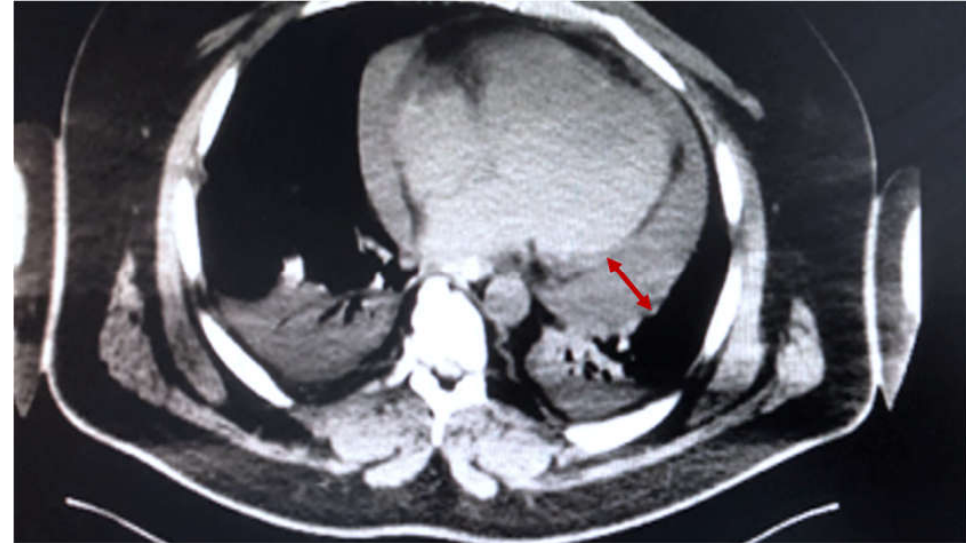
Figure 4. Thoracic CT scan showing circumferential pericardial fluid ( Case 4 ) .